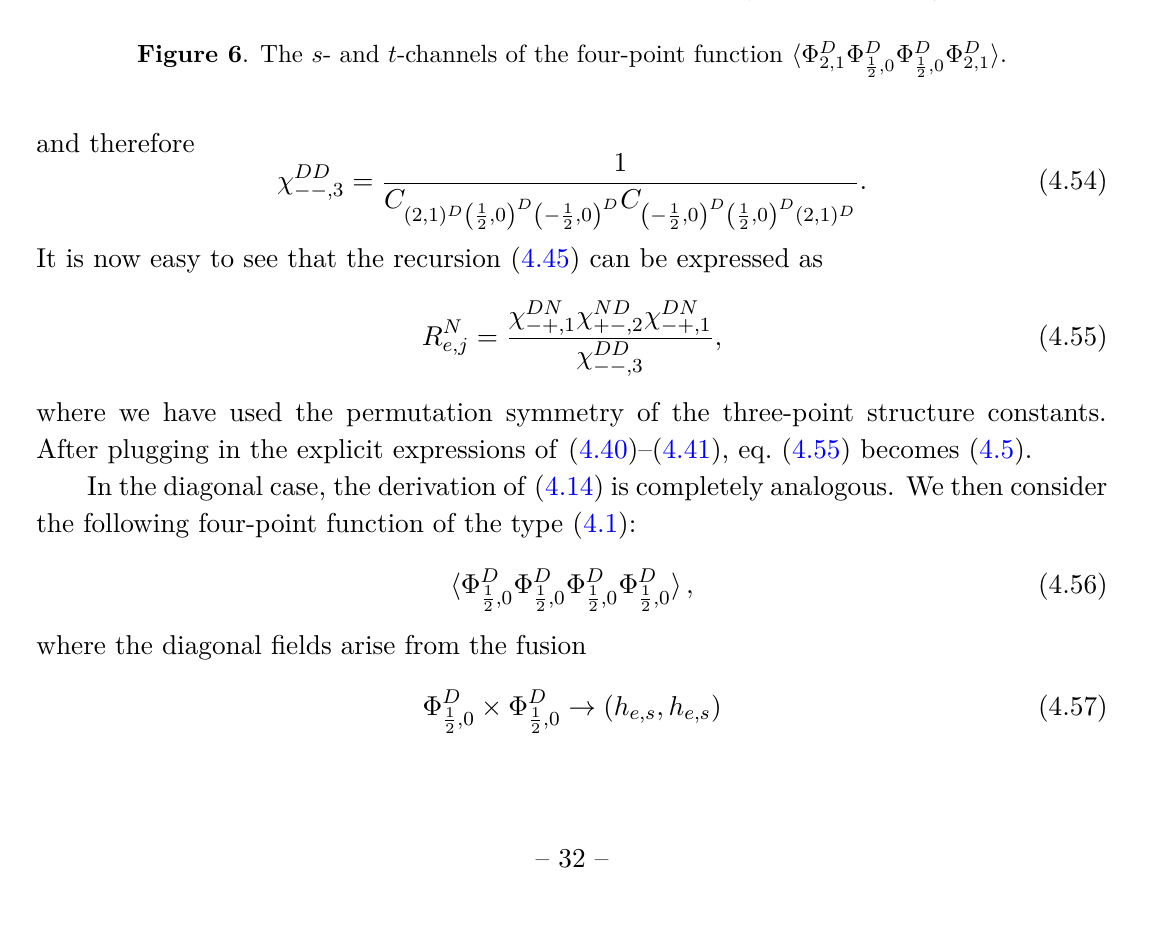
Figure 6 . The s - and t -channels of the four-point function h Φ D